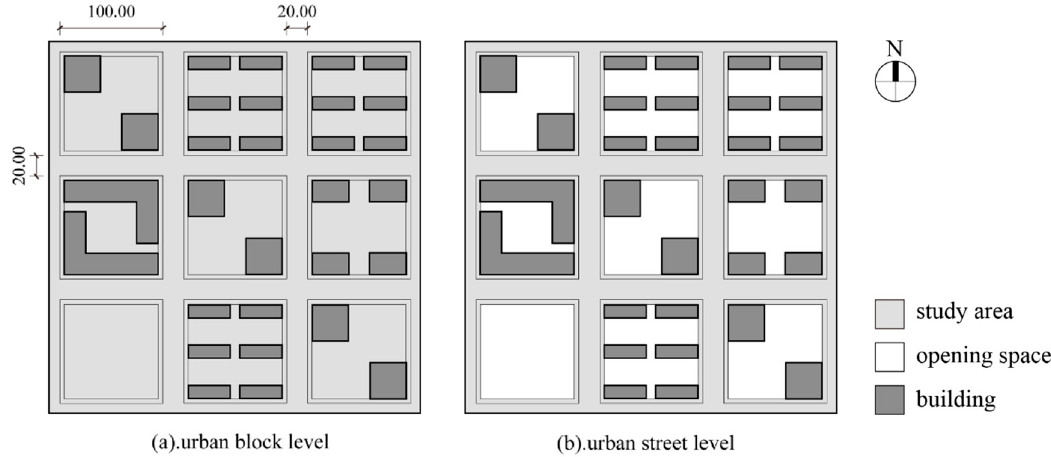
Figure 4. Test plane range: ( a ) urban block level and ( b ) urban street level. Table 2. Parameter settings and boundary conditions during optimization.